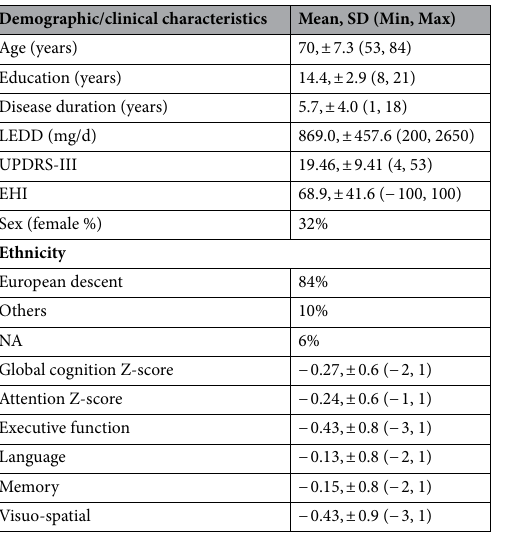
Table 1. The demographic and clinical characteristics. Abbreviations; LEDD = Levodopa Equivalency Daily dosage, UPDRS-III = Unified Parkinson’s disease Rating Scale part III, EHI = Edinburg Handedness Inventory, NA = Not